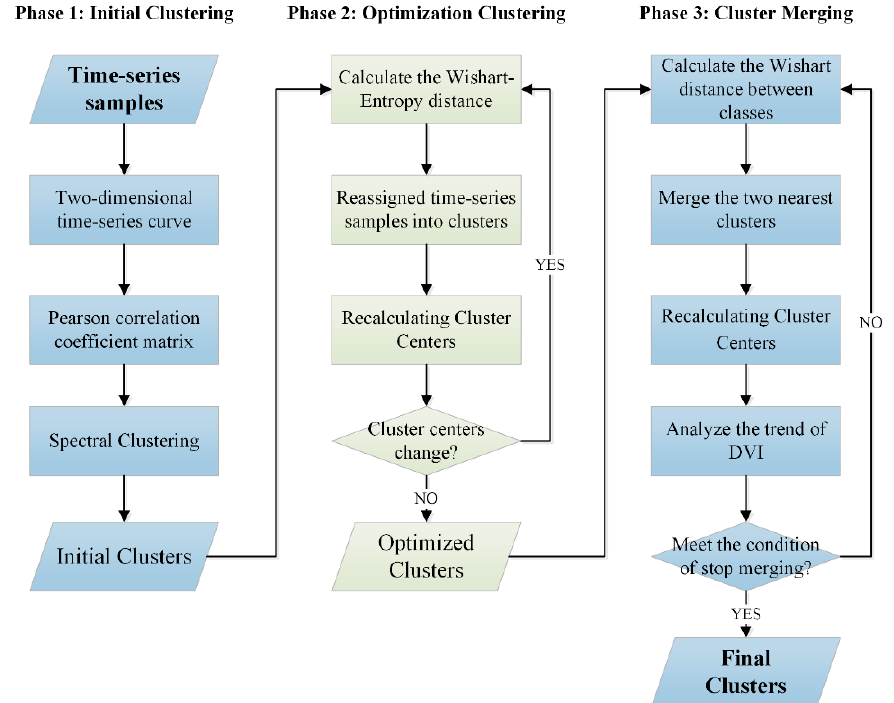
Figure 2. Flow chart of the three-phase time-series clustering algorithm. DVI: Dunn validity index.